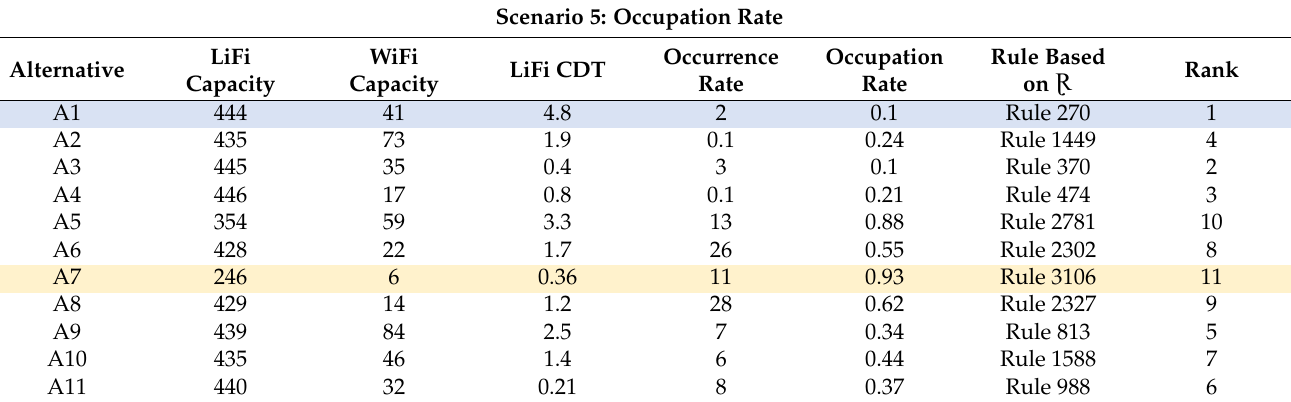
Table 13. Using Criteria #5 (occupation rate) for ranking the best and worst alternatives. Scenario 5: Occupation Rate